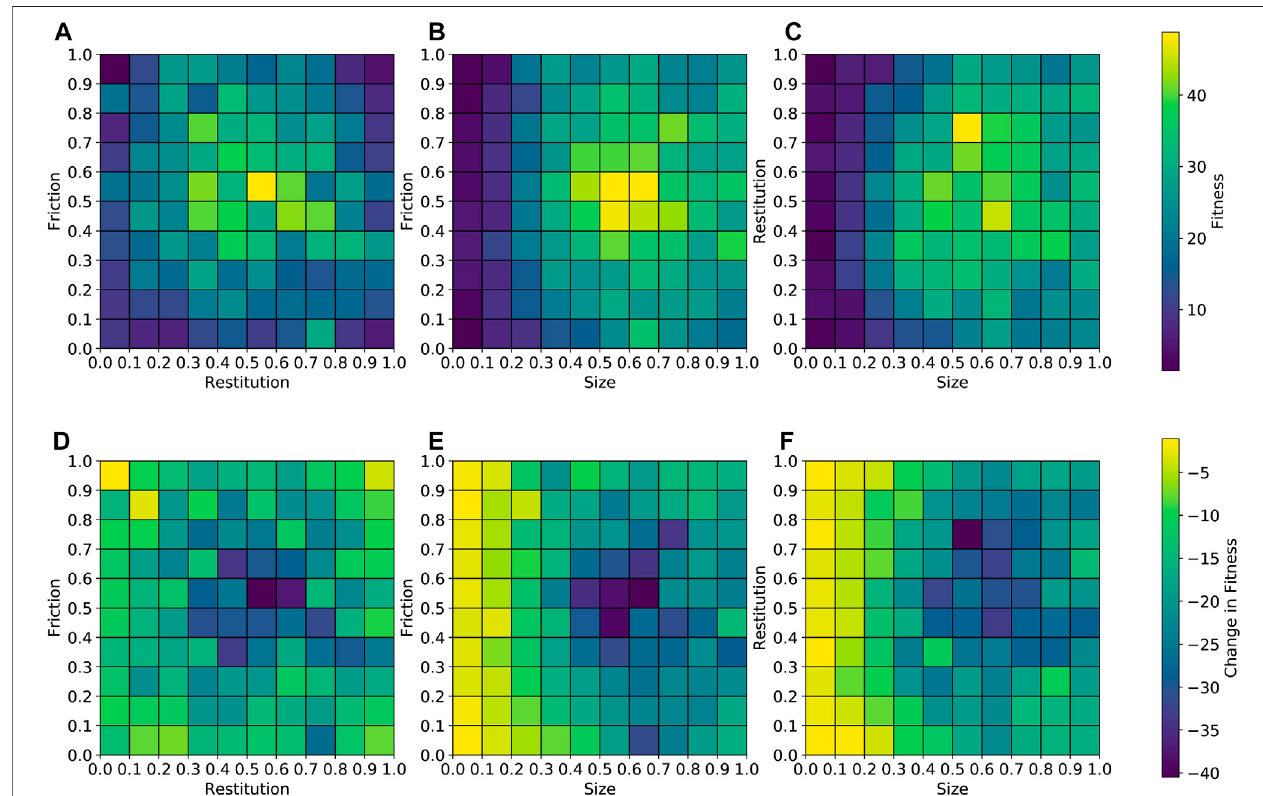
FIGURE 8 | Pair-wise feature- fi tness plots for the high friction surface. Plots A, B, and C show an aggregated view of how performance varies across the feature space. Plots D, E, and F show the effect of transferring the same solutions on to the low friction surface. Fitness refers to the distance covered by the robot in the x -direction. All feature values have been normalized between 0 and 1.